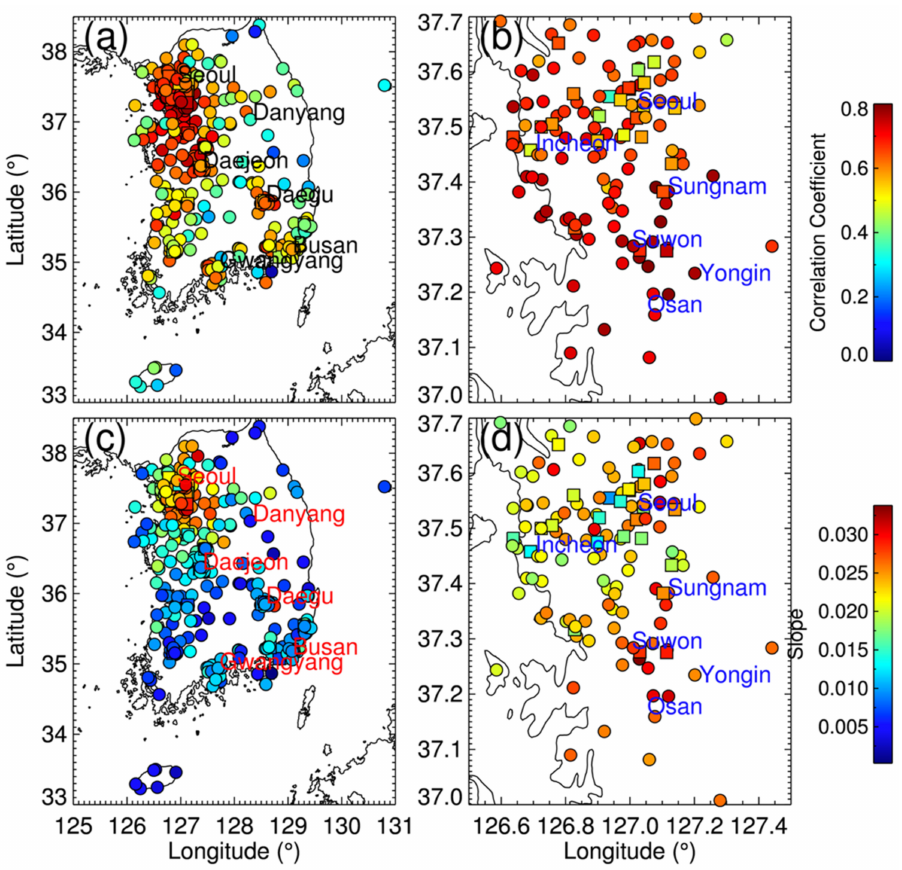
Figure 6. Correlation coefficients between C TROPOMI and S KME at the KME monitoring stations over ( a ) South Korea and ( b ) Seoul metropolitan area for 2019. The panels ( c ) and ( d ) represent the slope of the plot (with S KME as the x -axis and C TROPOMI as the y -axis) at each site. Circles represent ambient air-quality monitoring sites, and squares represent roadside air-quality monitoring